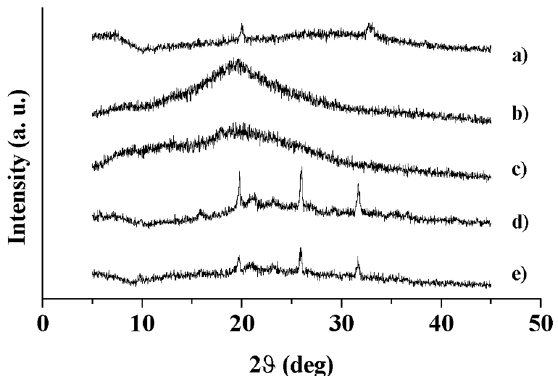
Figure 4. X-ray diffraction patterns of: SAP (a), HA MS (b), HA-CL MS (c), HA–SAP MS (d), HA-CL–SAP MS (e).